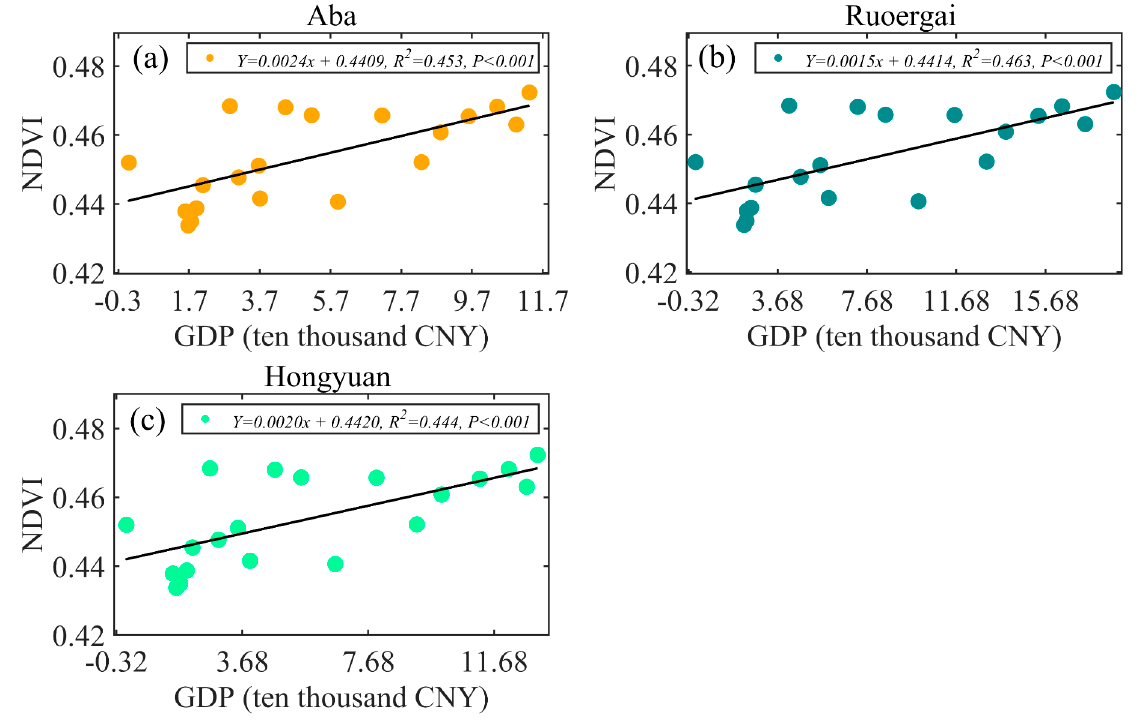
Figure 9. Linear regression analysis between the GDP and NDVI at the county level. Note: ( a ) Aba; ( b ) Ruoergai; and ( c ) Hongyuan.